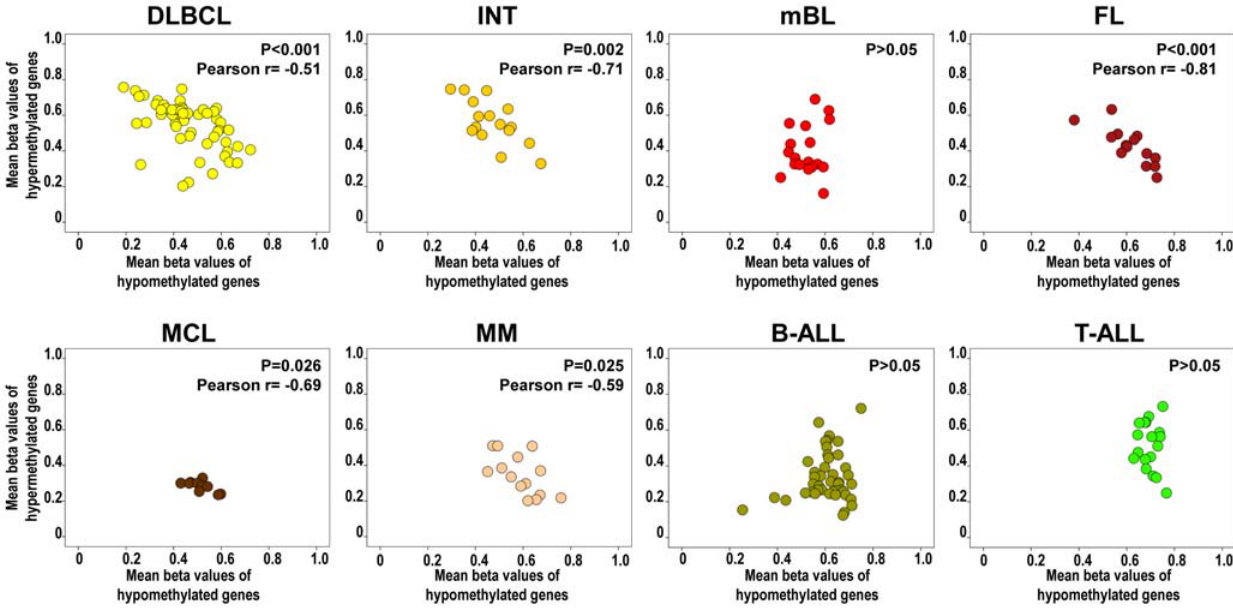
Figure 5. Scatter plots of mean methylation values of hypermethylated genes (Y axis) and hypomethylated genes (X axis) in HNs with more than 10 hypermethylated genes. This figure shows that there is a significant correlation between the level of DNA hypermethylation (increasing beta values) and DNA hypomethylation (decreasing beta values) in cases diagnosed with DLBCL, INT, FL, MCL and MM. In contrast, such phenomenon is not observed in mBL and precursor lymphoid leukemias like B-ALL and T-ALL.